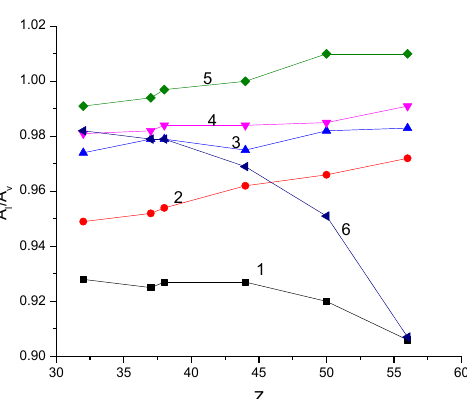
Figure 2. Ratios of length to velocity forms of rates for various transitions from 2s 2 2p 2 P° 1/2 state. Here 1, 2, 3, 4, 5, 6 represent transitions to 2s2p 2 4 P 1/2 , 2s2p 2 4 P 3/2 , 2s2p 2 2 D 3/2 , 2s2p 2 2 P 1/2 , 2s2p 2 2 P 3/2 , and 2s2p 2 2 S 1/2 state, respectively.